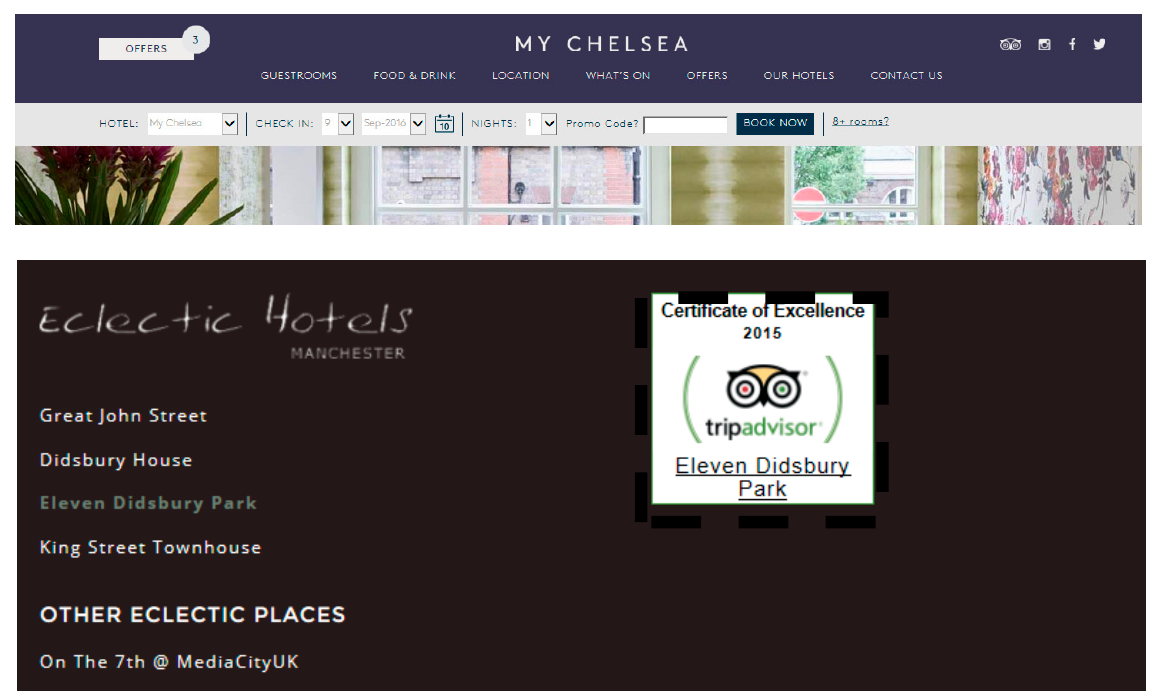
Games 2021 , 12 , x FOR PEER REVIEW Figure A2. The rating is ‘one-click away’ or a distinct link exists to their TripAdvisor rating.